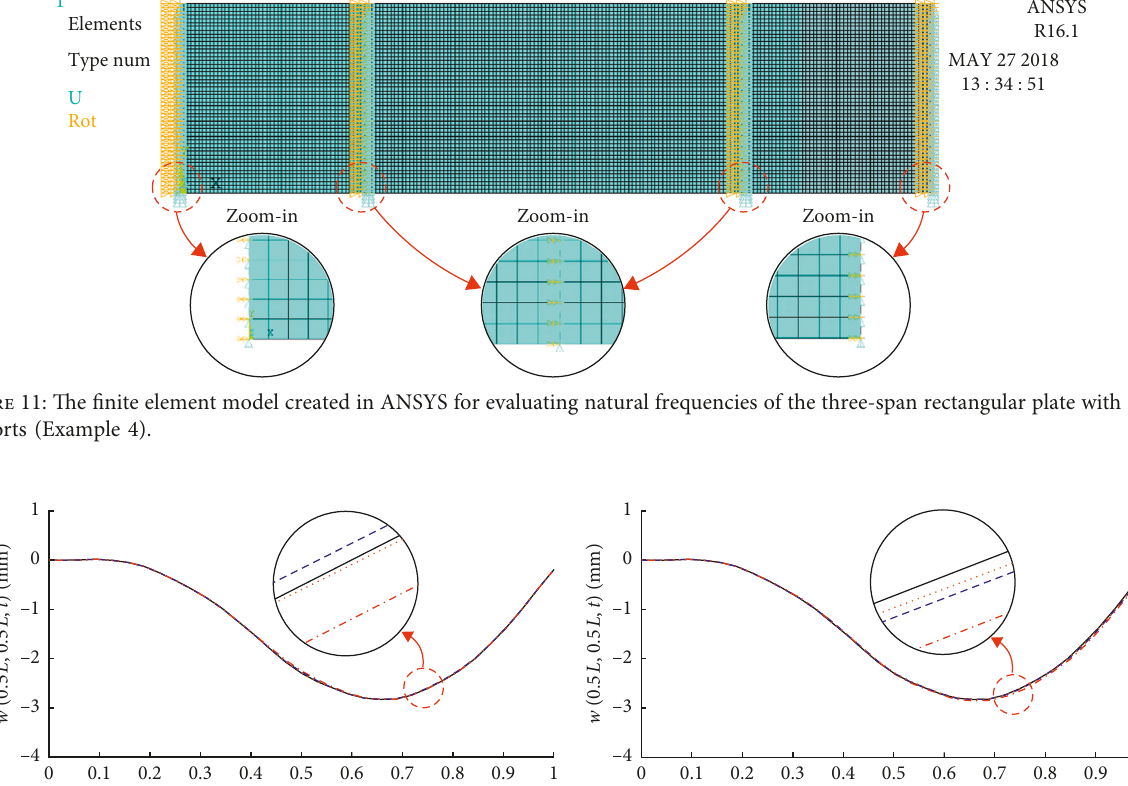
5m/s. (a) ITM (cid:31)